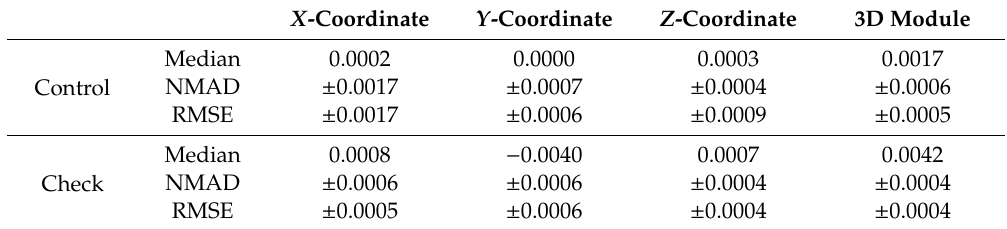
Table 3. Gaussian and robust estimation of the residuals of the control and check points. Units: meters. X -Coordinate Y -Coordinate Z -Coordinate 3D